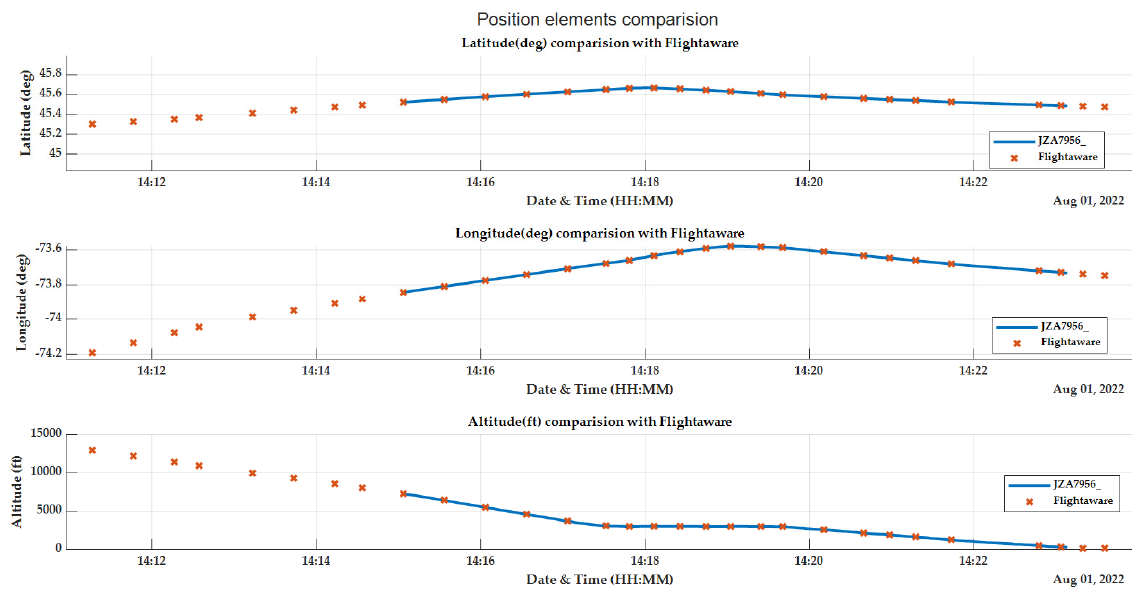
Figure 17. Position elements (latitude, longitude, and altitude) comparison with FlightAware data.